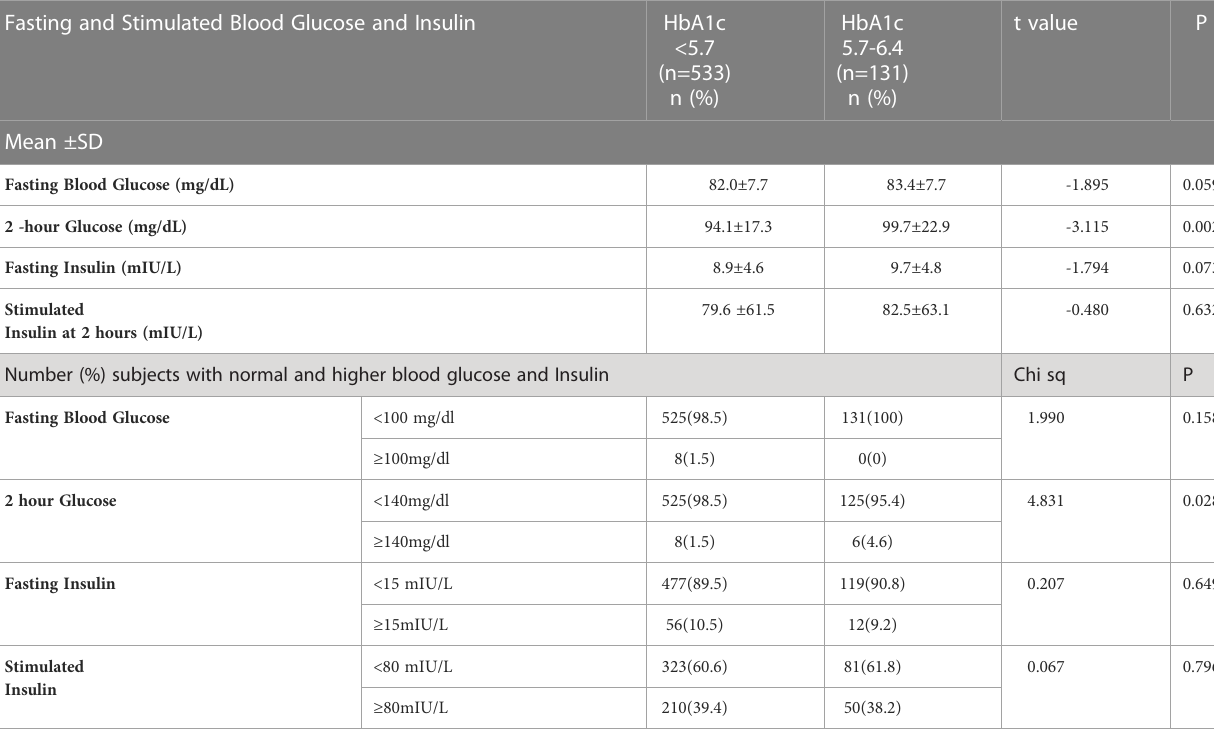
TABLE 3 Comparison of blood glucose and insulin in persons with normal HbA1c (<5.7) and prediabetics (HbA1c: 5.7-6.4). Fasting and Stimulated Blood Glucose and Insulin